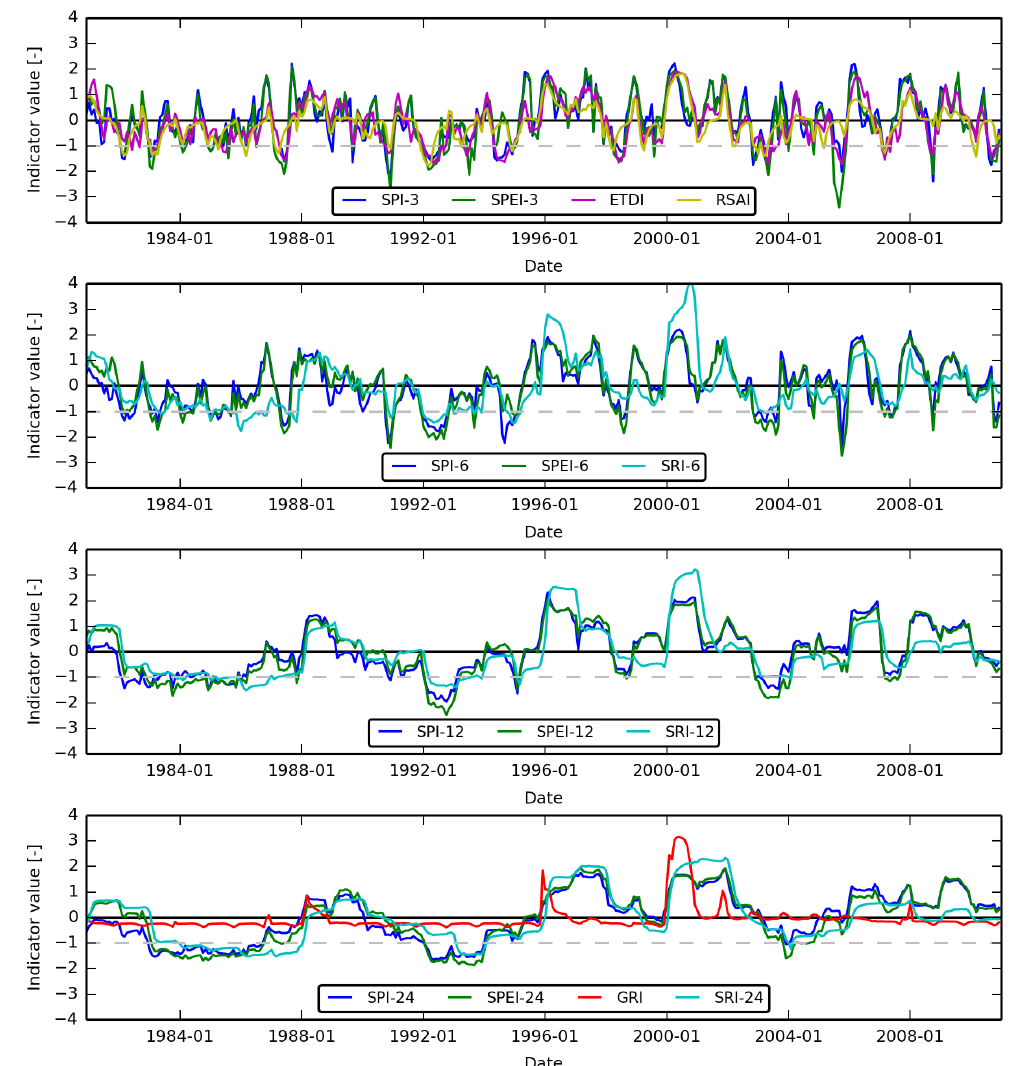
Figure 8. Same as Fig. 6, but for subbasin